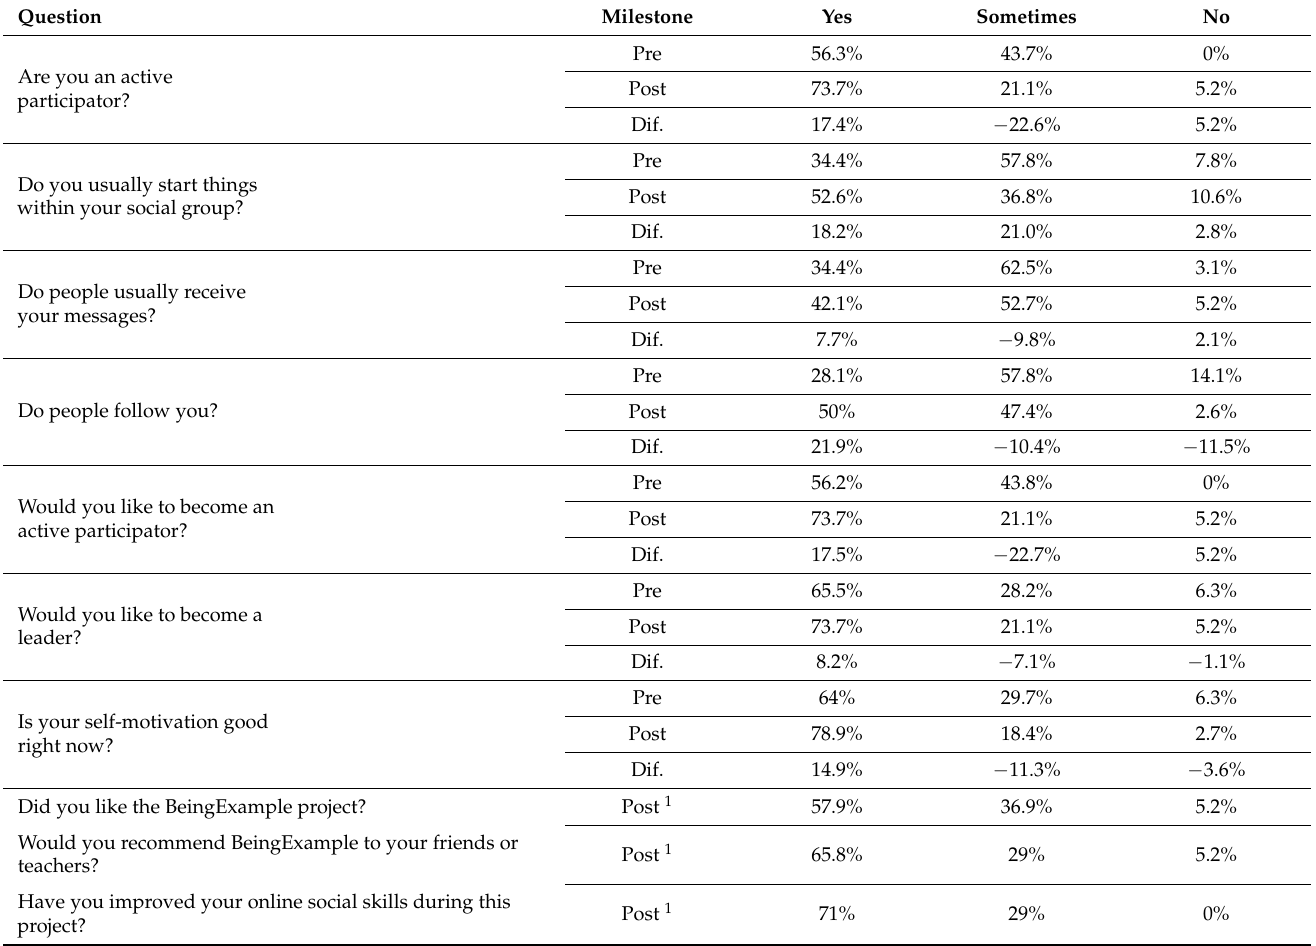
Table 7. Anonymous survey on social skills comparing the use of